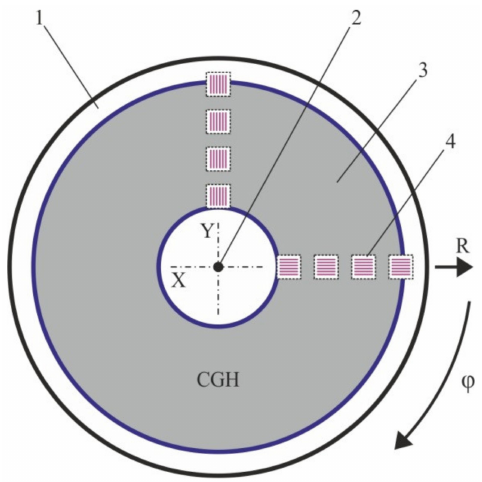
Figure 5. Layout of two chains of coordinate marks with 90 degrees shift for circular writing systems. 1—optical substrate, 2—axis of rotation of the optical substrate, 3—CGH, 4—small window areas with coordinate